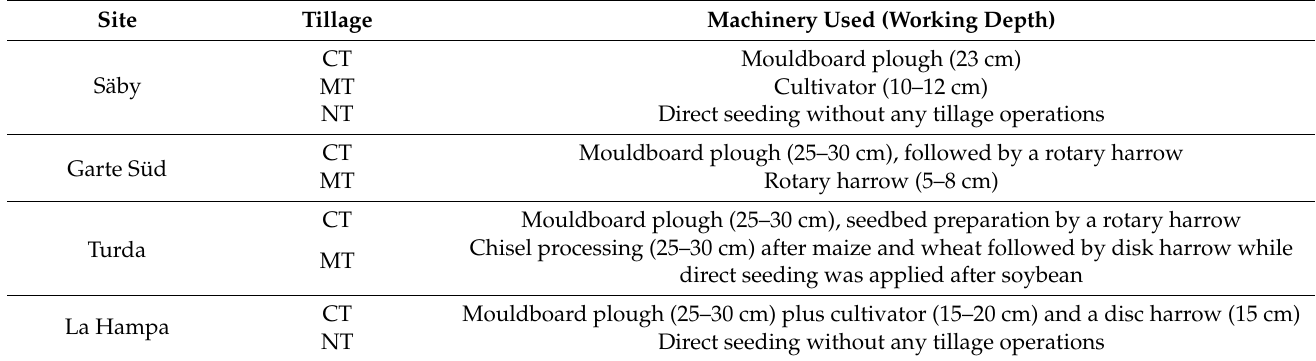
Table 2. Mean (standard deviation) of bulk density, soil organic carbon (SOC) and total nitrogen (N)